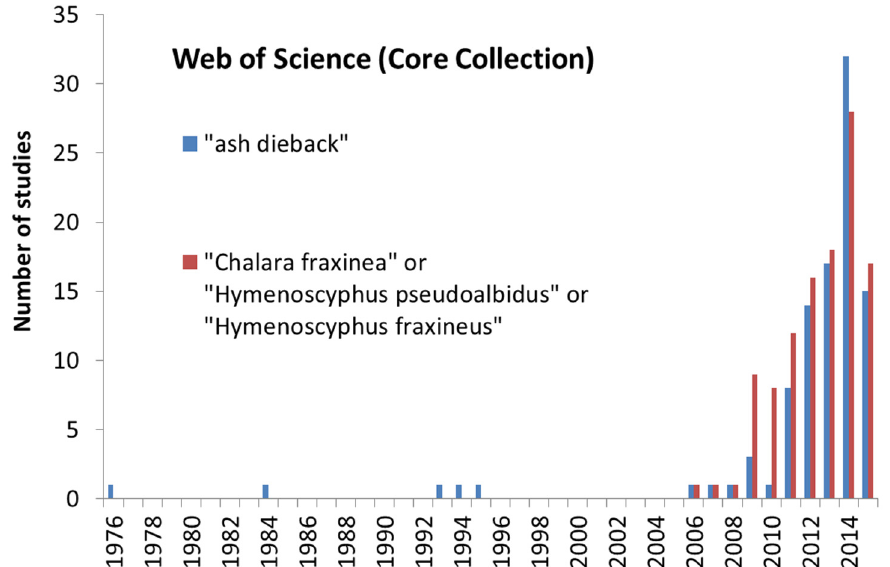
Figure 1. Temporal trend in Web of Science (core collection, since 1975), as of September 2015, of the number of studies retrieved with the keywords “ash dieback” (total = 98) and the names of its causal agent (“ Chalara fraxinea ” OR “ Hymenoscyphus pseudoalbidus ” OR “ Hymenoscyphus fraxineus ”) (total = 111), an ascomycete shown in 2006 to be responsible for the dieback of Fraxinus excelsior in Europe [30–32]. Note that many relevant studies are not included in this database. Even so, the sudden increase in research shown by the figure is likely to reflect what happened in reality.